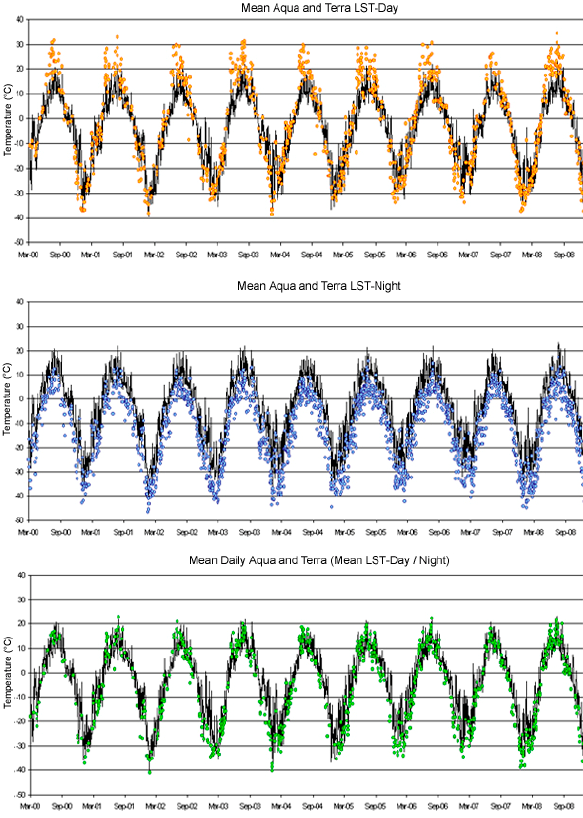
Fig. 3. Comparison between the mean LST (a) combined Terra/Aqua Day acquisitions (orange dots), (b) combined Terra/Aqua Night acquisitions (blue dots), and (c) combined Terra/Aqua Day/Night acquisitions (green dots), with mean daily T air (black line) forIB1 pixel on Imnavait Basin site.